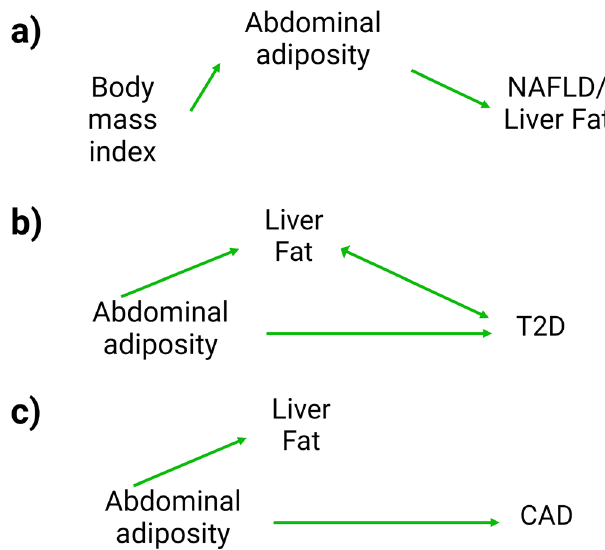
Fig. 5 Schematic illustration of the main fi ndings of the study. a Both genetically-predicted body mass index and abdominal adiposity are associated with non-alcoholic fatty liver disease (NAFLD) and liver fat accumulation. However, the relationship between genetically-predicted BMI and NAFLD/liver fat accumulation is entirely mediated by genetically- predicted abdominal adiposity. b Genetically-predicted abdominal adiposity and NAFLD/liver fat accumulation are both associated with type 2 diabetes (T2D) and their associations with T2D are largely independent from one another. Genetically-predicted T2D is also associated with NAFLD/liver fat accumulation. c Genetically-predicted abdominal adiposity, but not genetically-predicted NAFLD/liver fat accumulation is associated with coronary artery disease (CAD). The association between genetically- predicted abdominal adiposity and CAD is not mediated by NAFLD/liver fat